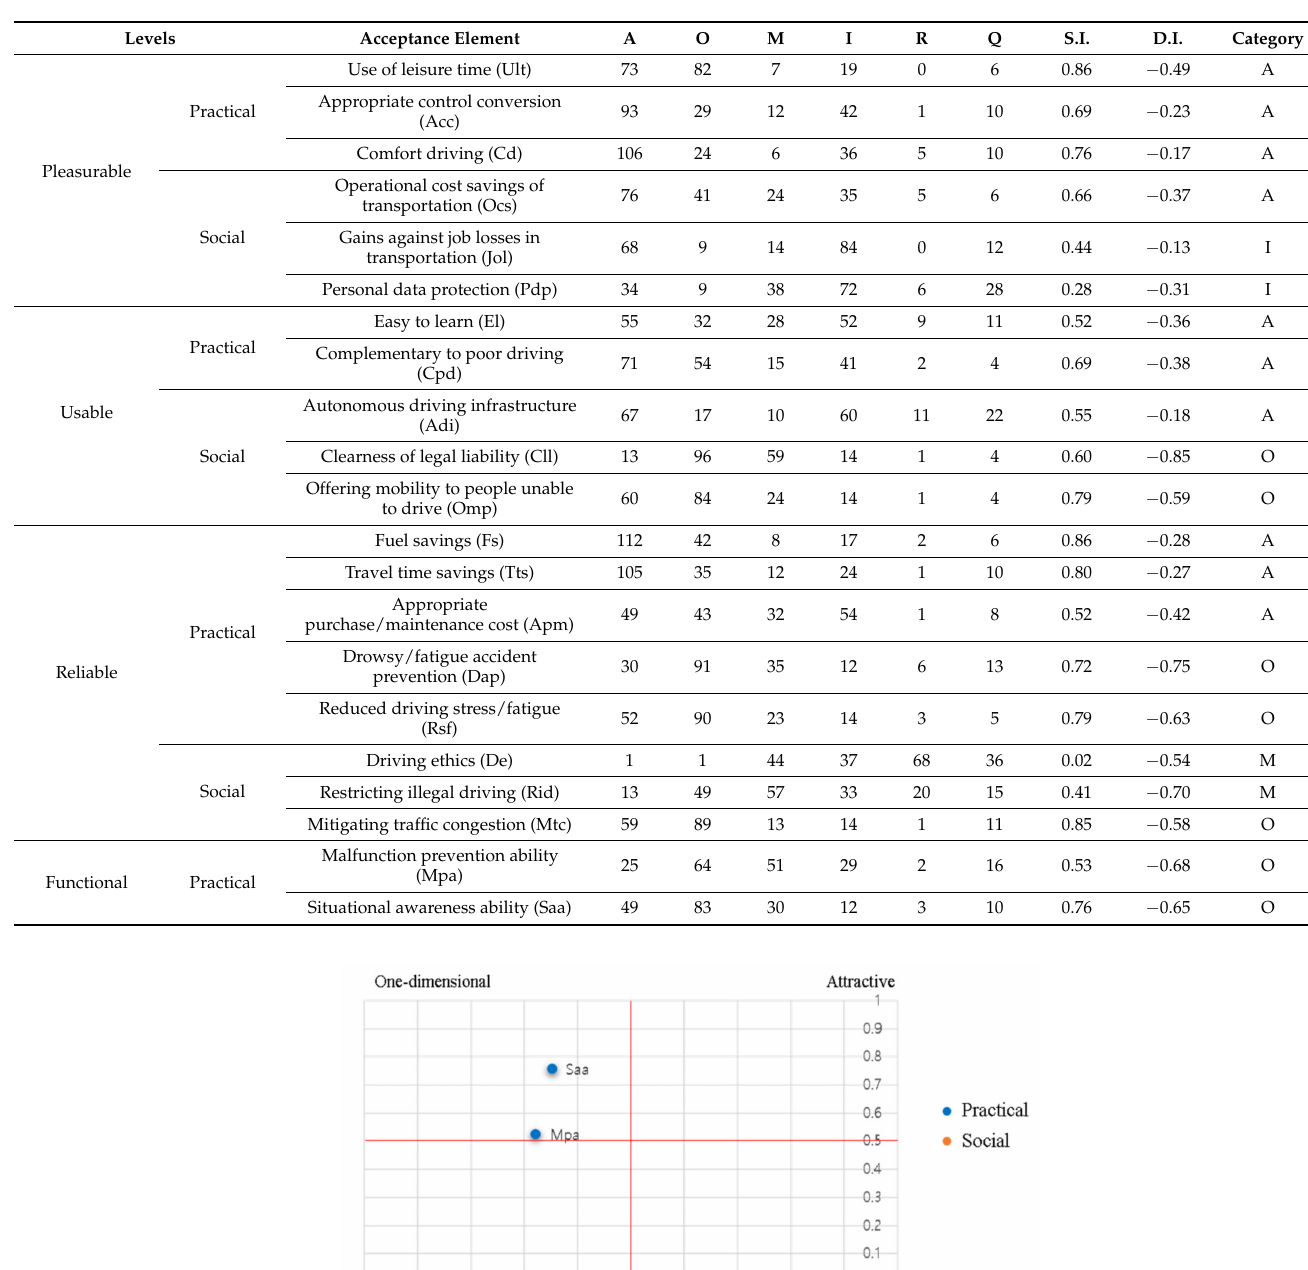
Table 5. Categorized results of acceptance elements.